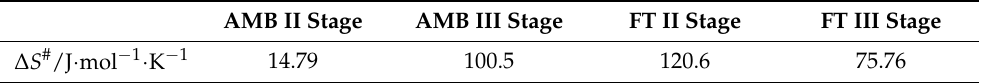
Table 5. The value of ∆ S # , J · mol − 1 · K − 1 for the II and III stages of AMB and FT decomposition